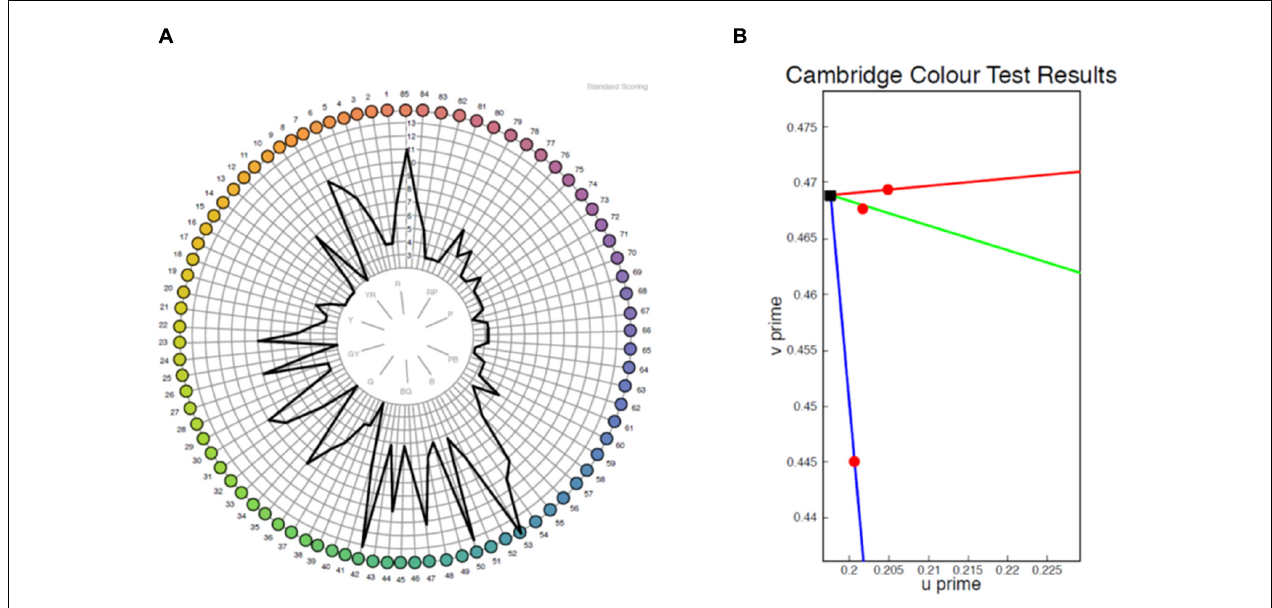
FIGURE 5 | Representative sample of a test result for the same eye from the FM 100 Hue (A) and low vision Cambridge Color Test (lvCCT) (B) . The FM 100 Hue does not have a clearly definable axis of color loss, whereas the lvCCT results indicate a reduced tritan score (longer vector) but normal protan and deutan scores as shown by the short